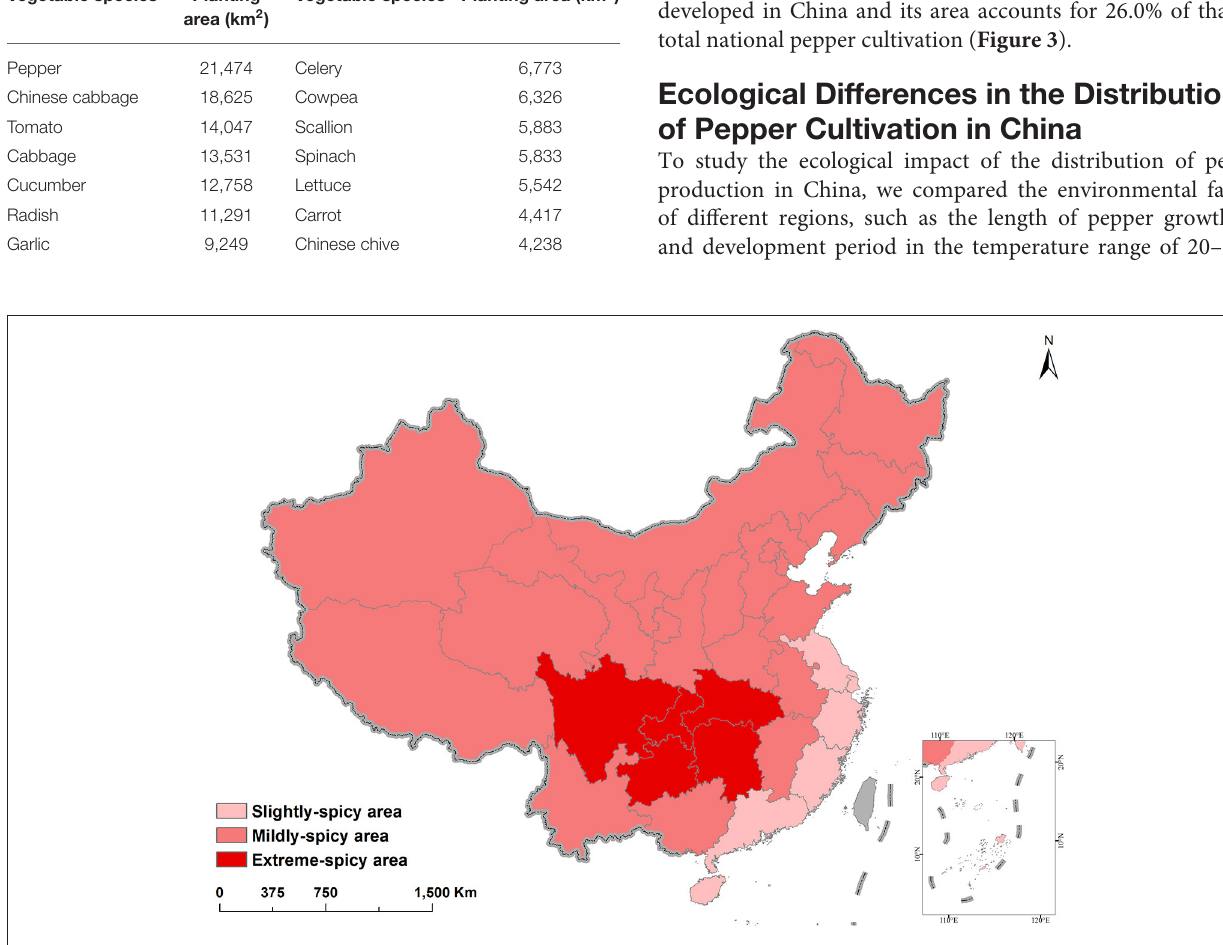
Frontiers in Nutrition |